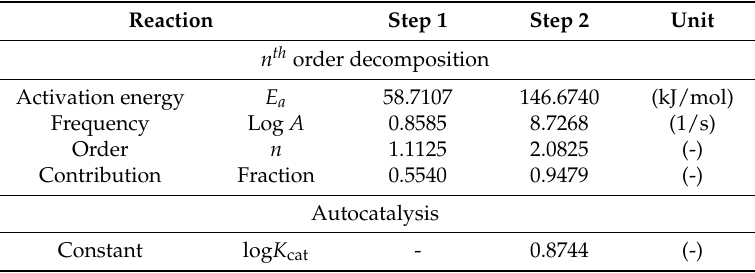
Table 3. Kinetic parameters determined for the decomposition of the T700/M21 composite.